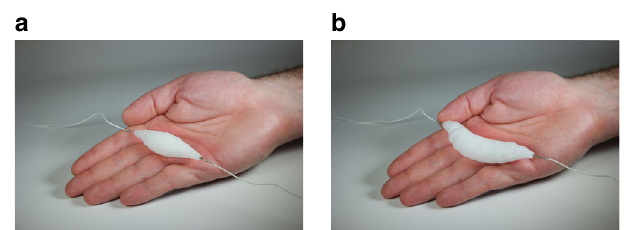
Fig. 1 Soft arti fi cial muscle. The muscle is composed of ethanol distributed throughout the solid silicone elastomer matrix. a Electrically actuated muscle including thin resistive wire in a rest position on a human hand.